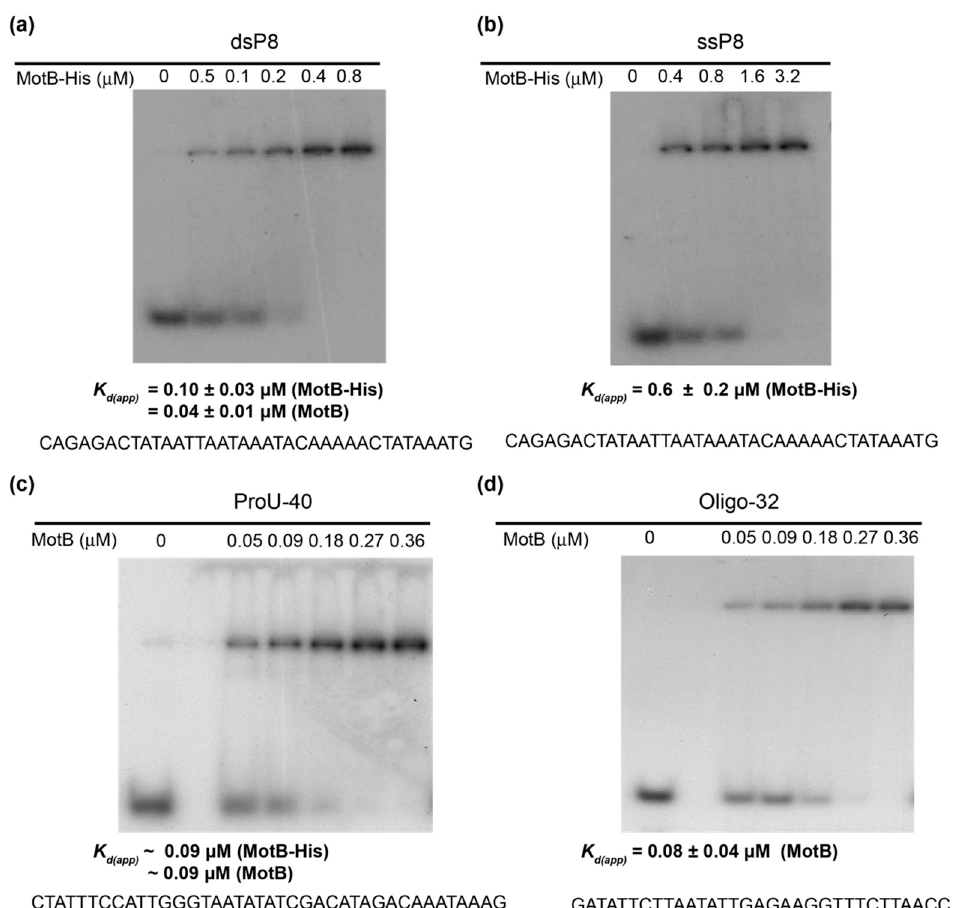
Figure 3. MotB binds ds and ssDNA. Representative EMSAs for MotB and MotB-His binding to ( a ) 37 bp P8 oligonucleotide, which contains the T4 Pl 8 promoter from − 29 to +8 (dsP8); ( b ) the top strand of the P8 oligonucleotide (ssP8); ( c ) a 40 bp fragment containing the E. coli proU operon from +8 to +47 (ProU-40); and ( d ) a random 32 bp oligonucleotide (Oligo-32). DNA (1 nM) was incubated with the indicated concentrations of MotB or MotB-His at 37 C for 10 min before electrophoresis on a native polyacrylamide gel. The corresponding K d(app) is shown below each gel along with the DNA sequence of the top strand. Three independent replicates were performed for each oligonucleotide, except for ProU-40, which was done once with MotB and once with MotB-His.